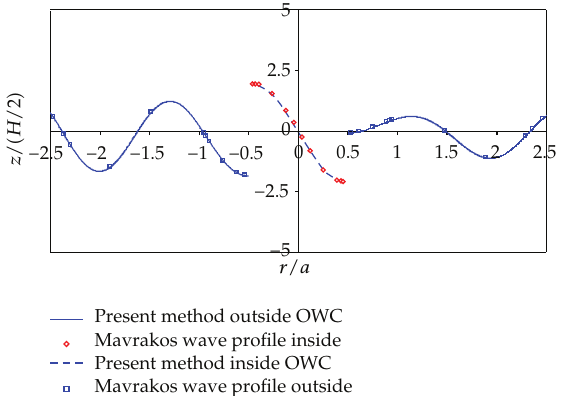
Figure 9: Wave profile inside and outside OWC device for a wave period T (cid:8) 6 .